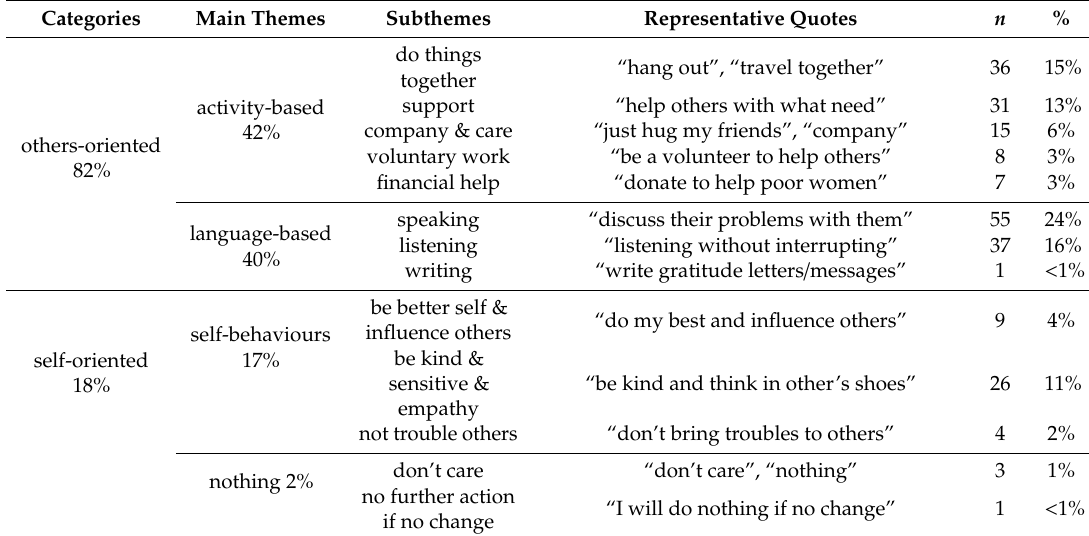
Table 4. Activities participant have or plan to engage in to support other’s